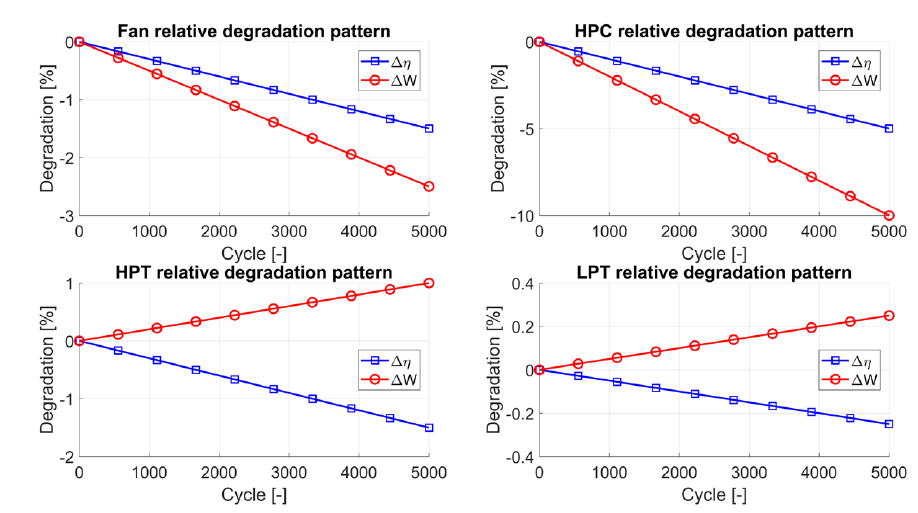
Figure 4. Relative degradation pattern used as target data.